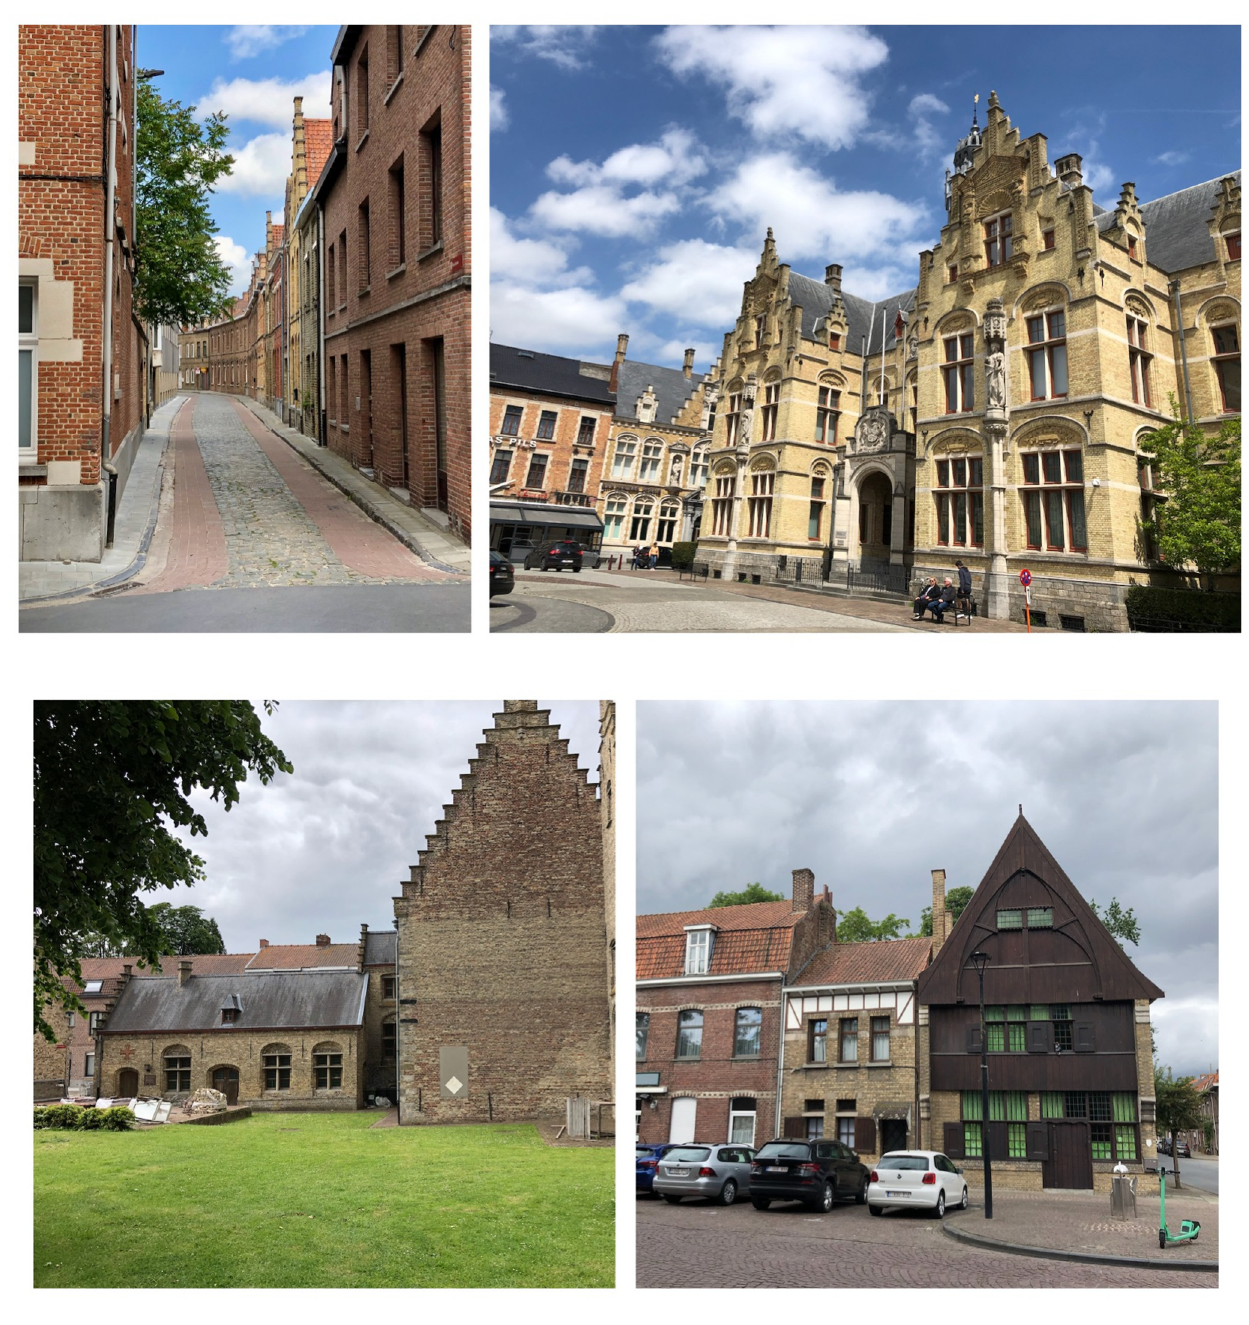
Figure 2. City of Ypres nowadays.